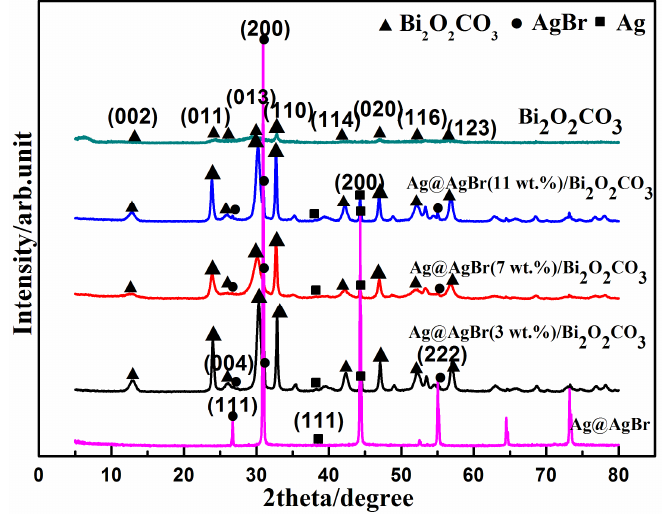
Figure 1. XRD patterns of the as-synthesized pure Bi 2 O 2 CO 3 , Ag@AgBr and Ag@AgBr/Bi 2 O 2 CO 3 photocatalysts: 3 wt %, 7 wt %, and 11 wt % Ag@AgBr/Bi 2 O 2 CO 3 composites.